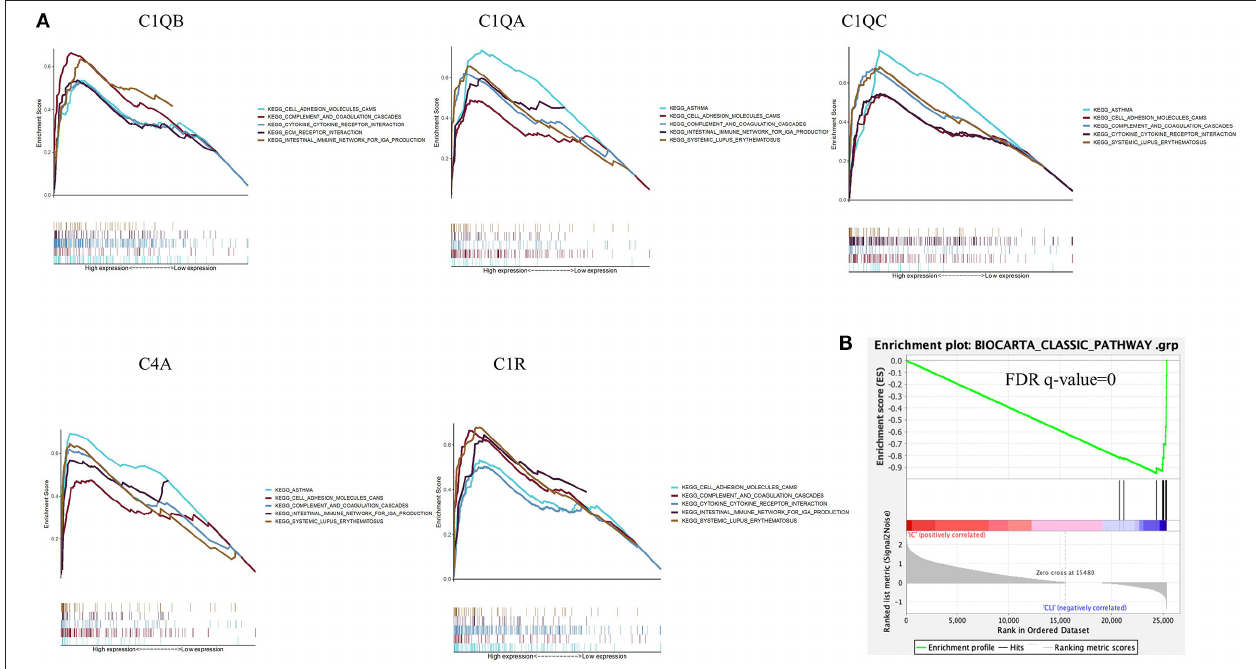
FIGURE 7 | Gene set enrichment analysis. (A) A merged enrichment plot of C1QB, C1QA, C1QC, C4A, and C1R from gene set enrichment analysis, including enrichment score and gene sets. (B) The classical complement gene sets were significantly activated in CLTI tissues compared with IC tissues. IC, intermittent claudication; CLTI, chronic limb-threatening